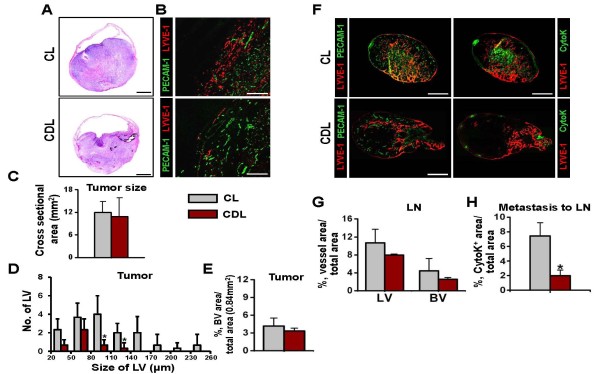
Depletion of CD11b+/CD68+ TAM reduced OUBC-induced lymphangiogenesis and lymphatic spread of bladder cancer cells. 1 × 106 MBT-2 cells were injected into the urinary bladders of 8-10-week old female C3H mice. 2 weeks after the tumor cell injection, clodronate liposome (CDL) or control liposome (CL) were injected intraperitonealy to the OUBC mice once every 3 days. 4 weeks after the tumor cell injection, the bladder and SLN were sampled. (A) Images showing H&E stained sections of tumors. Scale bars, 2 mm. (B) Comparison of cross-sectional area of tumors. Graph shows mean ± SD; n = 5 for each group. (C) Images showing LYVE-1+ LVs and PECAM-1+ BVs in tumors. Scale bars, 200 μm. (D) Comparison of LV numbers at different sizes of LV in the tumor sections. Graph shows mean ± SD; n = 5 for each group. *p < 0.05 versus CL. (E) Comparision of BVD per total sectioned area of tumors. Graph shows mean ± SD; n = 5 for each group. (F) Left panel; images showing LYVE-1+ LVs and PECAM-1+ BVs in LNs. Right panel; images showing LYVE-1+ LVs and CytoK+ metastatic cancer cells in LNs. Scale bars, 500 μm. (G) Comparison of LVD and BVD in LNs. Graph shows mean ± SD; n = 5 for each group. (I) Comparison of densities of CytoK+ metastatic cancer cells in LNs. Graph shows mean ± SD; n = 5 for each group. *p < 0.05 versus CL.